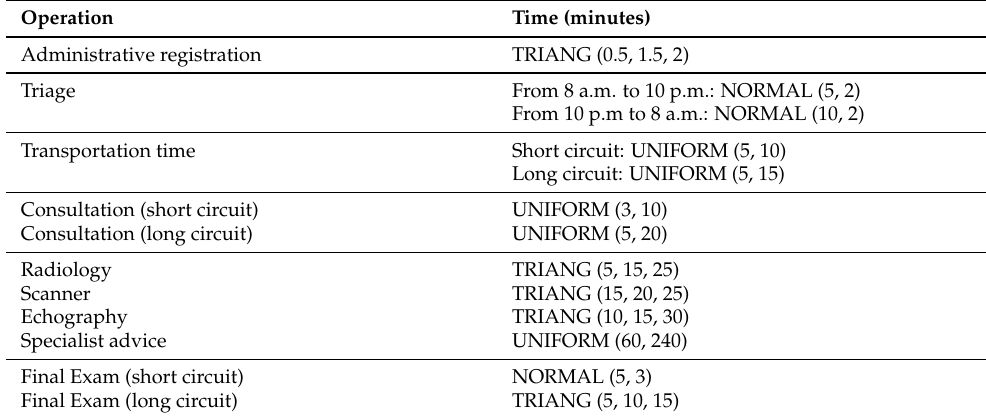
Table 1. Synthesis of the processing time